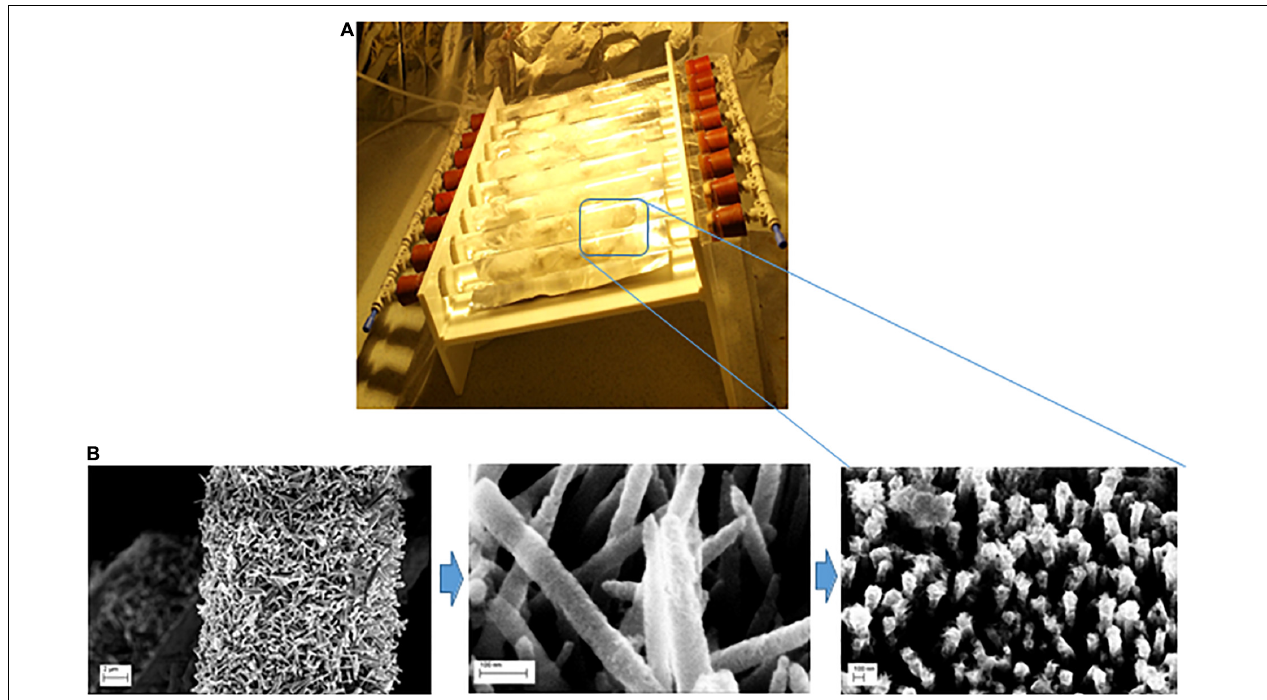
FIGURE 1 | (A) Schematic diagram of the photocatalytic reactor used in this work (Uheida et al., 2021); (B) the fabrication process of ZnO NRs coated with SnO2 layer and decporated decorated with Fe0 NPs grown on glass fibers.